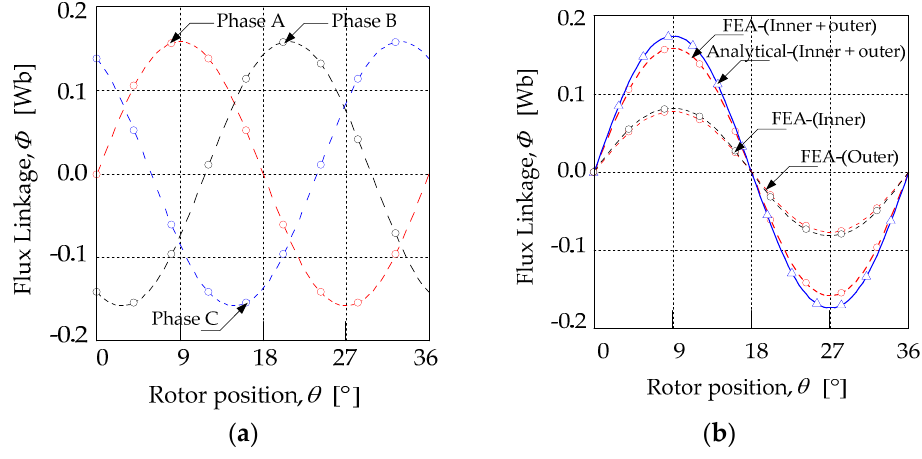
Figure 12. Flux linkage of DSSR-PMG, ( a ) FEA simulation; ( b ) FEA simulation and analytical.